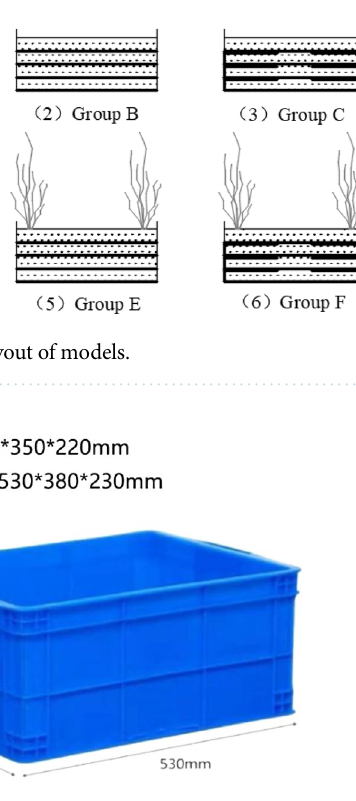
Figure 2. Particle grading curve.